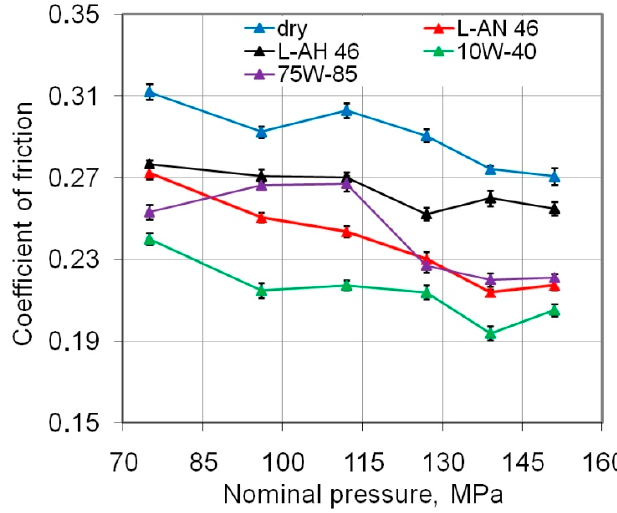
Figure 5. Effect of friction conditions on the value of the COF. Due to the non-linear relationship between the clamping force and friction force, the value of COF decreases with increasing pressure. This relationship, typical for a strip- drawing test with cylindrical counter-samples, was also found by Kirkhorn et al.